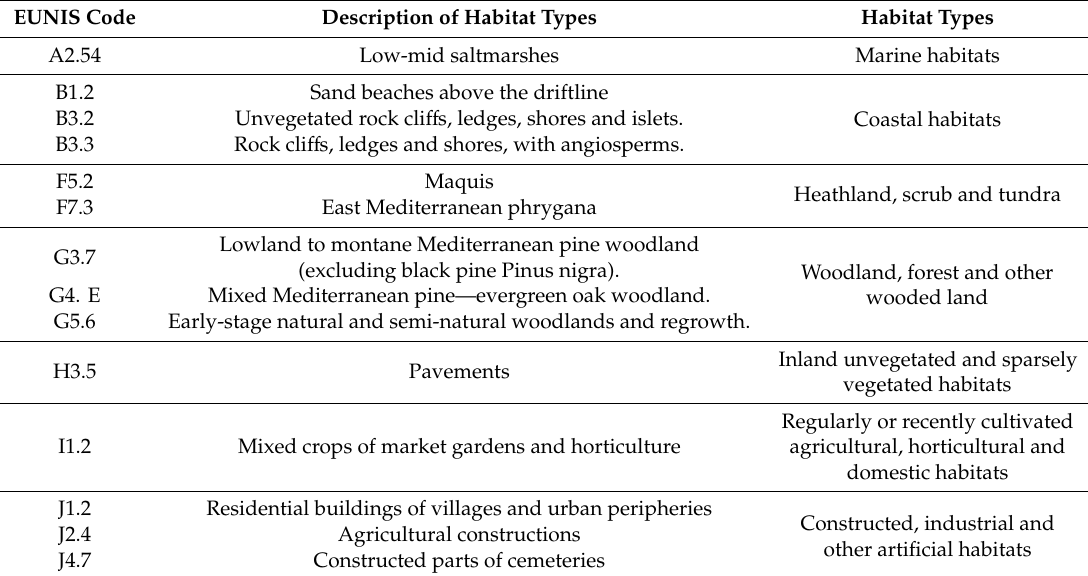
Table 2. EUNIS Habitat types in Kas-Kekova PA [36].